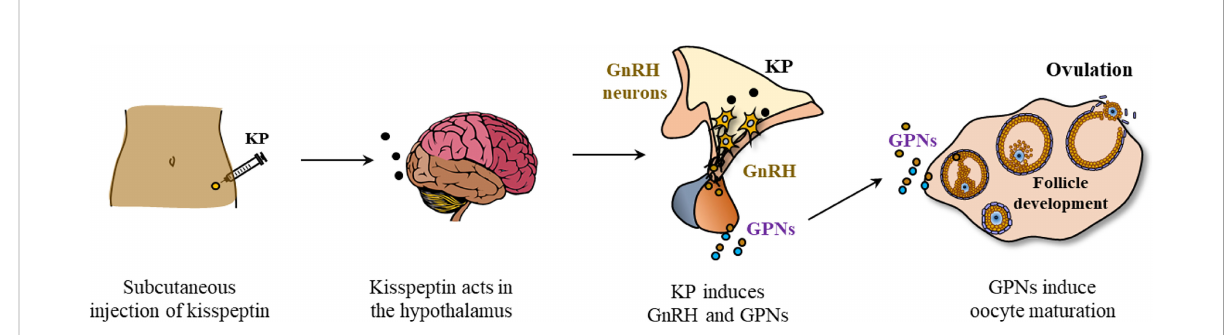
FIGURE 5 Kisspeptin induced oocyte maturation in patients undergoing in vitro fertilization. Exogenous kisspeptin (i.e., KP-54) administered at peripheral sites (subcutaneously) can reach the GnRH neurons in the hypothalamus and stimulate GnRH expression. GnRH acts on the pituitary gonadotrophs to induce gonadotropins (GPNs, LH and FSH) that act on the ovarian follicles to induce oocyte maturation and